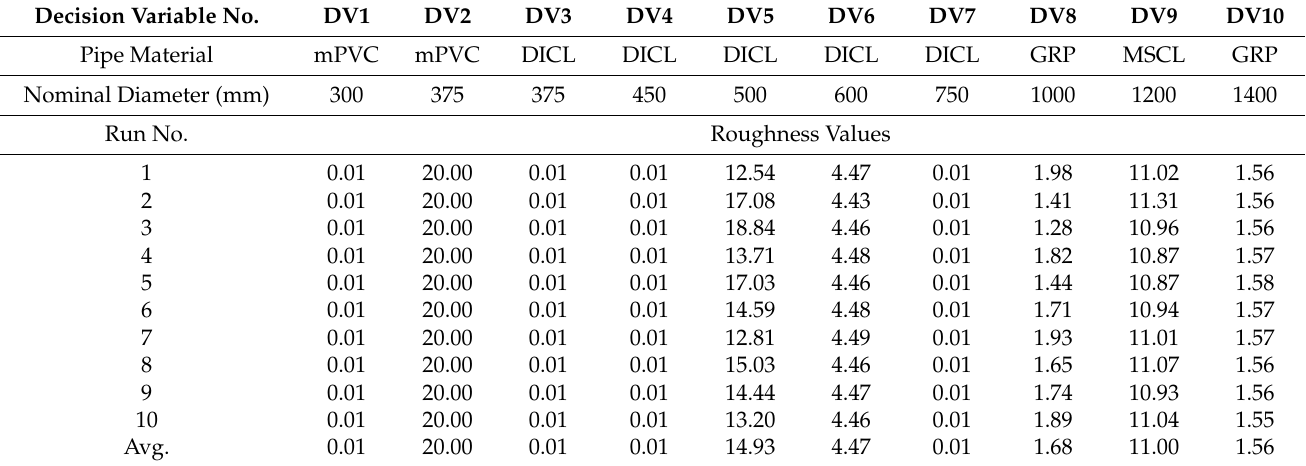
Table 5. Pipe roughness values obtained from Formulation 3 (10 DVs) with the SLSQP